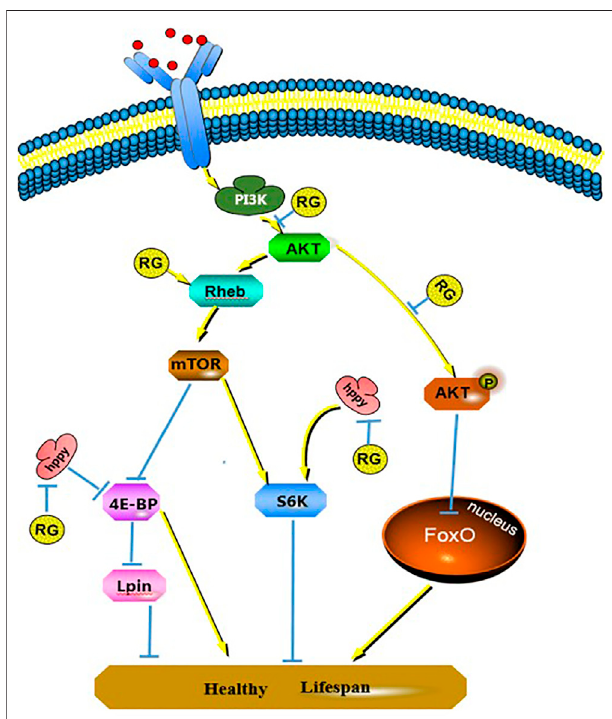
FIGURE8| ChangesofsignalpathwaysinducedbyRGprolongingmale D. melanogaster life span. P value < 0.05 was considered statistically signi fi cant.; Abbreviation: RG, red ginseng; Con, control; AKT, protein kinase B; mTOR, mechanistic target of rapamycin, PI3K, phosphatidylinositol 3 kinase; 4E-BP, eukaryotic translation initiation factor 4E binding protein; S6K, S6 protein kinase; FoxO, forkhead box O.